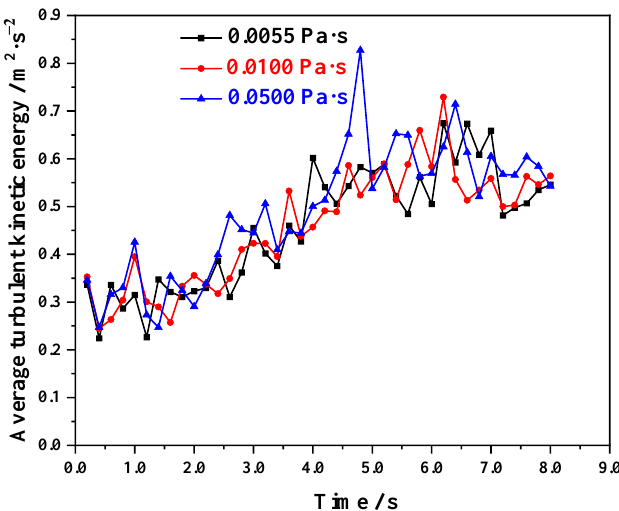
Figure 11. The average turbulent kinetic energy varies with time under different liquid densities (inlet velocity: 30 m/s, viscosity: 0.0055 Pa · s).